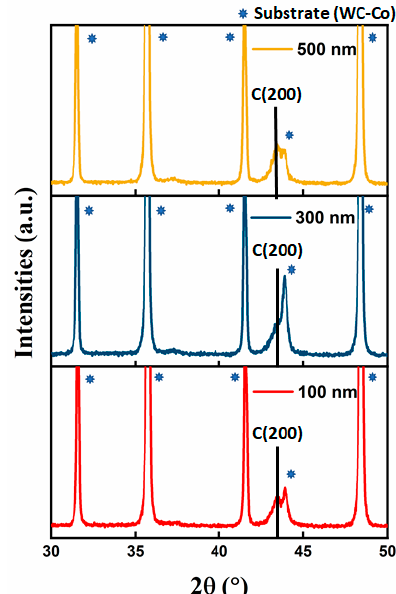
Figure 5. X-ray diffraction patterns of TiAlCrSiYN-based coatings with different interlayer thickness from 100 to 500 nm. Mark C represents the cubic (B1) phase.